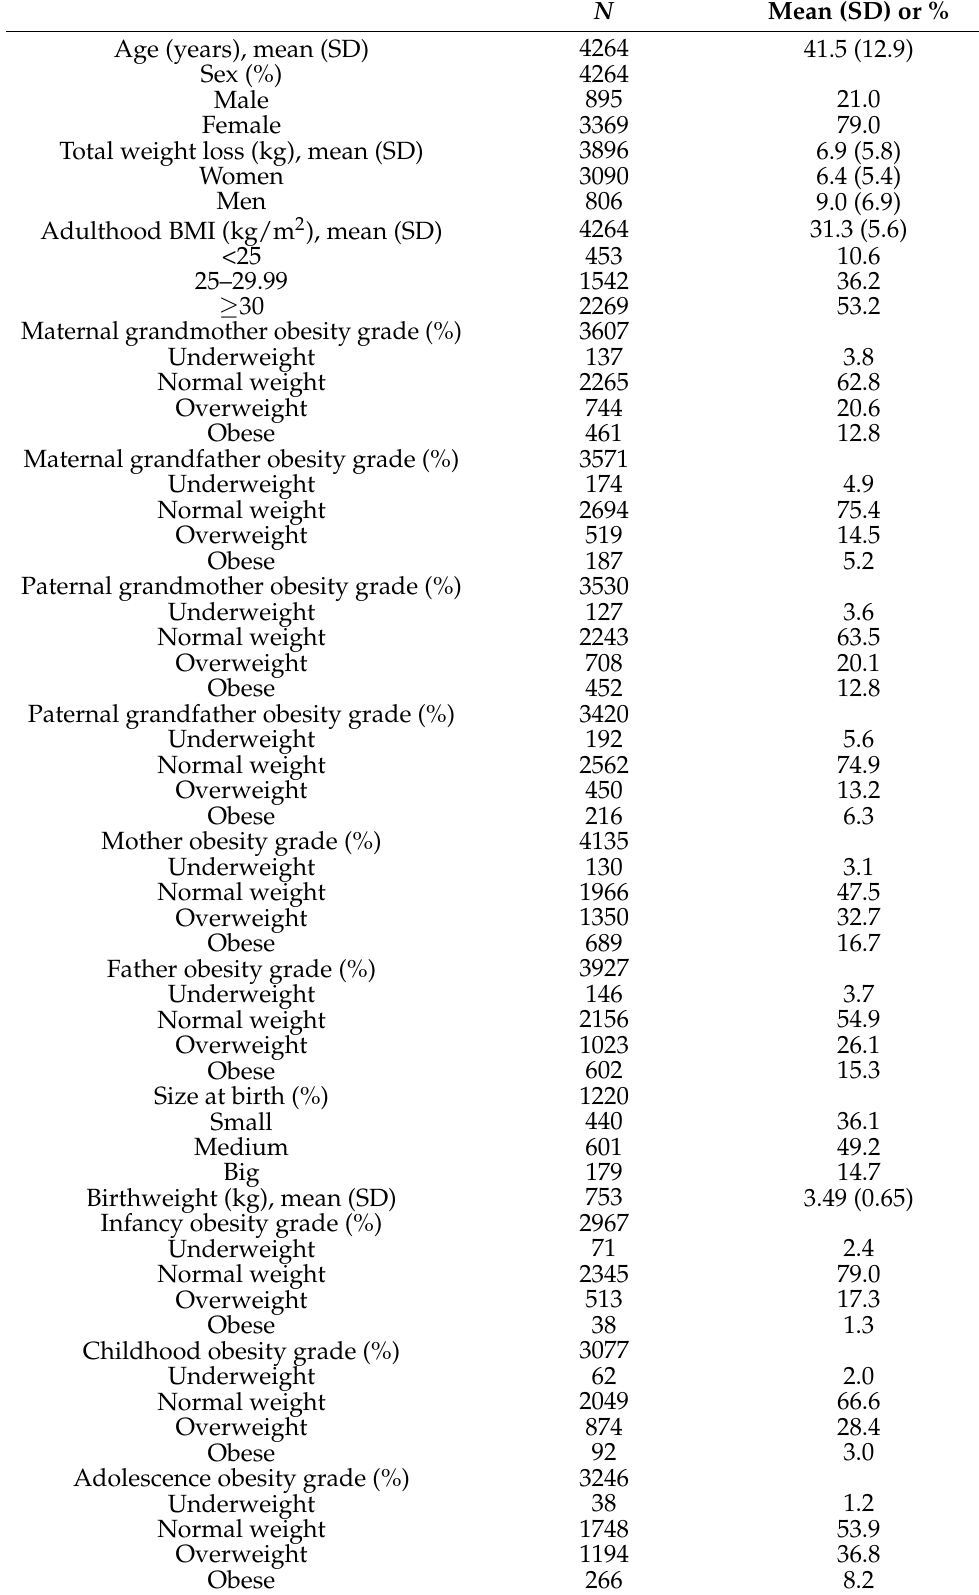
Table 1. Characteristics of the study